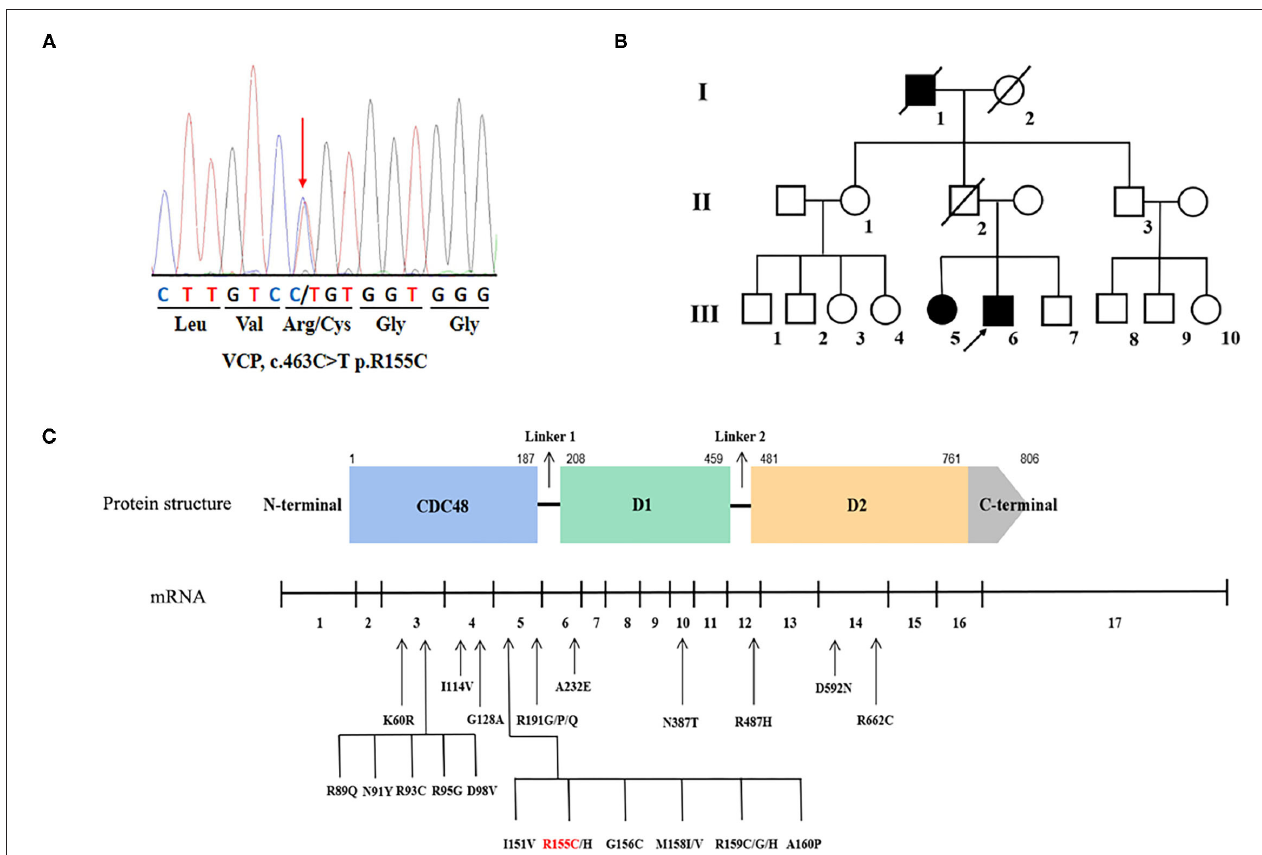
FIGURE 1 | Genetic information of the valosin-containing protein (VCP) mutation in our study and overview of the VCP mutations associated with amyotrophic lateral sclerosis (ALS). (A) Sequencing chromatograms of the VCP p.R155C mutation. (B) The pedigree of the familial ALS with VCP p.R155C mutation. Arrow indicates the index patient. (C) Schematic graph of the VCP protein and overview of the VCP mutations linked to ALS. The locations of mutations are depicted in the mRNA structure where exons are numbered 1–17.